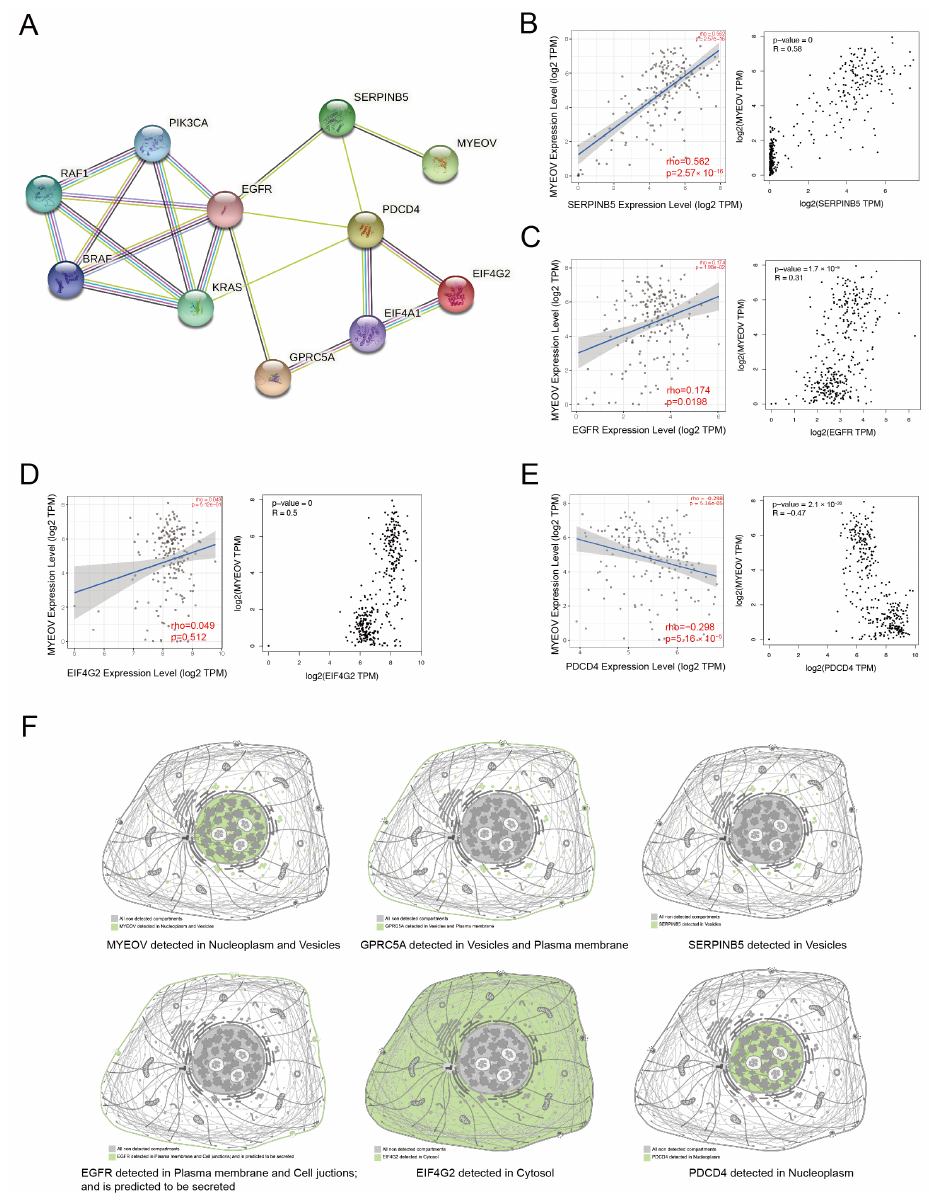
Figure 3. PPI analysis and molecular regulatory network of MYEOV. ( A ) MYEOV, GPRC5A, and KRAS had protein interactions with genes such as SERPINB5, EGFR, EIF4G2, and PDCD4. The light green lines indicate text mining, the black lines indicate co-expression, the purple lines indicate their relationship was experimentally determined, and the blue lines indicate their relationship was from curated databases. ( B ) MYEOV was significantly associated with SERPINB5 by the analysis of the Timer2 database and the GEPIA database. ( C ) MYEOV was significantly associated with EGFR by the analysis of the Timer2 database and the GEPIA database. ( D ) MYEOV was significantly associ- ated with EIF4G2 by the analysis of the Timer2 database and the GEPIA database. ( E ) MYEOV was significantly associated with PDCD4 by the analysis of the Timer2 database and the GEPIA data- base. ( F ) The subcellular localization of MYEOV, GPRC5A, SERPINB5, EGFR, EIF4G2, and PDCD4 proteins. 3.4. MYEOV as ceRNA for the Regulation of Multiple Genes A study has found that MYEOV can act as a ceRNA in tumors in the form of mRNA that binds to specific miRNAs, thus isolating the binding effect of miRNAs on target